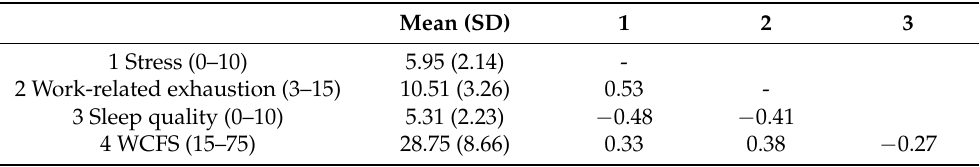
Table 3. Bivariate correlations between stress, work-related exhaustion, sleep quality, and cognitive failure symptoms (n =